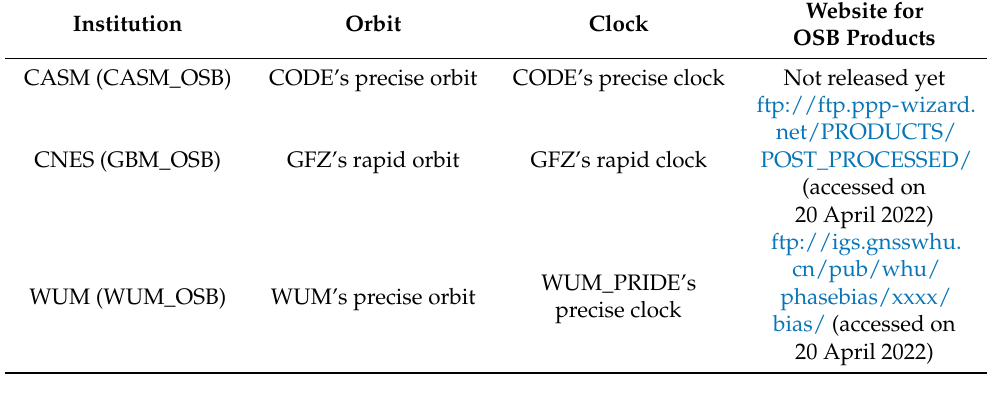
Table 3. Overview of the OSB products (The websites were accessed on 20 April 2022).